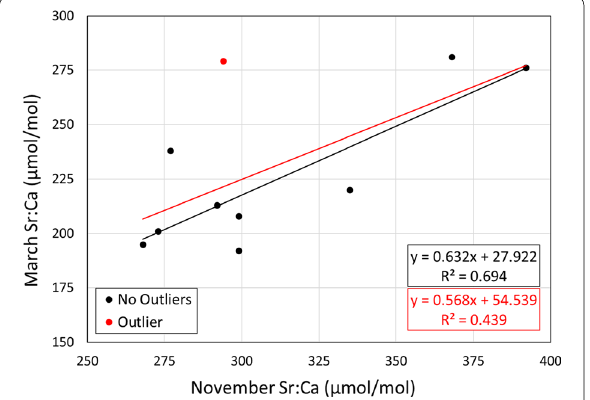
Fig. 8 Comparisons and linear best-fit lines for strontium (Sr) to calcium (Ca) ratios of lake sturgeon pectoral fin ray cross sections analyzed in both November 2015 and March 2016, with and without an outlier identified in Table 2